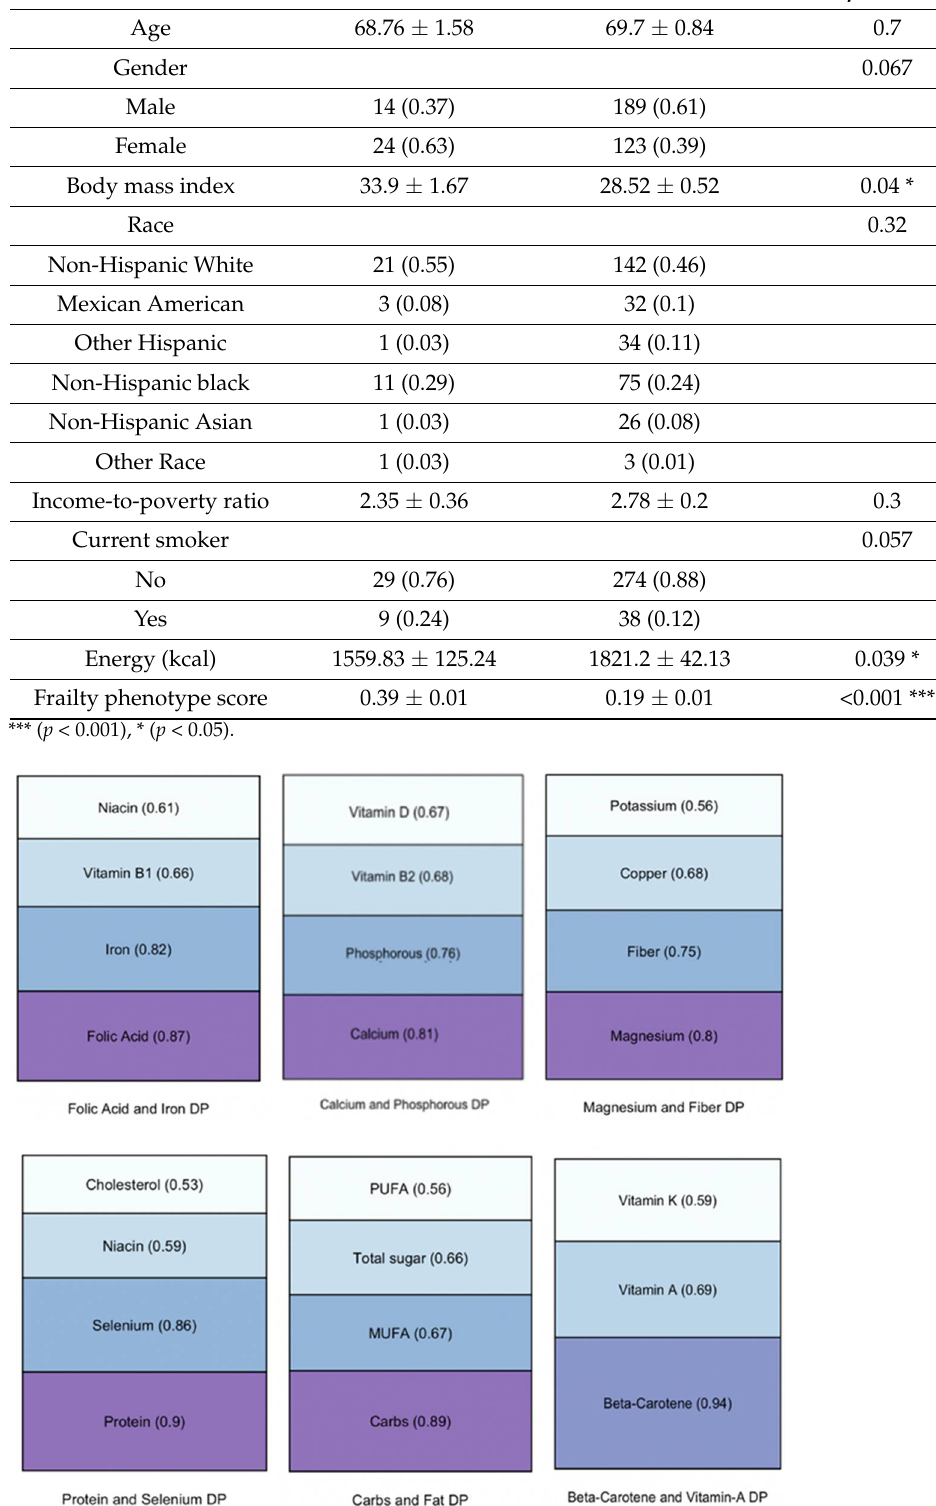
Figure 1. Composition of dietary patterns by largest component weights. Note MUFA = monosatu- rated fatty acid, PUFA = polysaurated fatty acid, DP = dietary pattern Fully adjusted multivariable linear regressions comparing DP scores between dysos- mic and normosmic groups (Table 3, Model 2) indicated that DP 3 (magnesium and fiber; p = 0.01), DP 4 (protein and selenium; p = 0.006), and DP 6 (β-carotene and vitamin A; p < 0.001) were significantly lower in the dysosmic group.